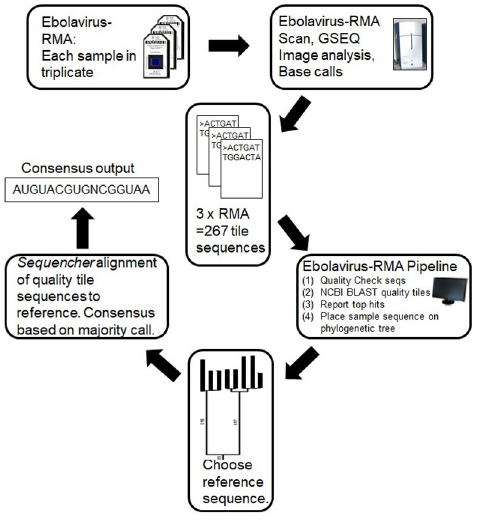
Fig 2. Flow chart of processing and analysis of Ebolavirus-RMA chip results. After hybridization and washing, Ebolavirus-RMA chips (N = 3 per RNA sample) are scanned and the output is generated in the form of FASTA files with the base calls in the tiles where enough hybridization occurred, corresponding to the region of one of the 4 Ebolavirus genomes. After quality filtering, the tile sequences above cutoff are searched against an in-house Filovirus specific database, FilovirDB, to identify the most similar sequence files. The combined sequences are also aligned against reference Ebola sequences, allowing the sample to be phylogenetically characterized to select the closest matching reference sequence. The reference sequence and original three FASTA files are then loaded into an alignment software and a consensus of the three Ebolavirus-RMA chips is generated.